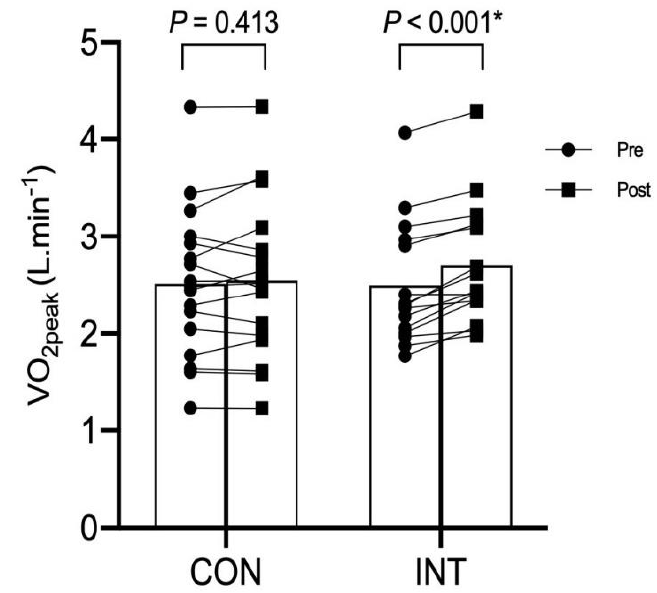
Figure 2. Peak oxygen uptake (or VO 2peak ) at pre- and post-6 weeks of training in the non-training or control (CON , N = 17) and intervention training (INT; N = 16) group. * Significance difference from pre-training in INT group only.